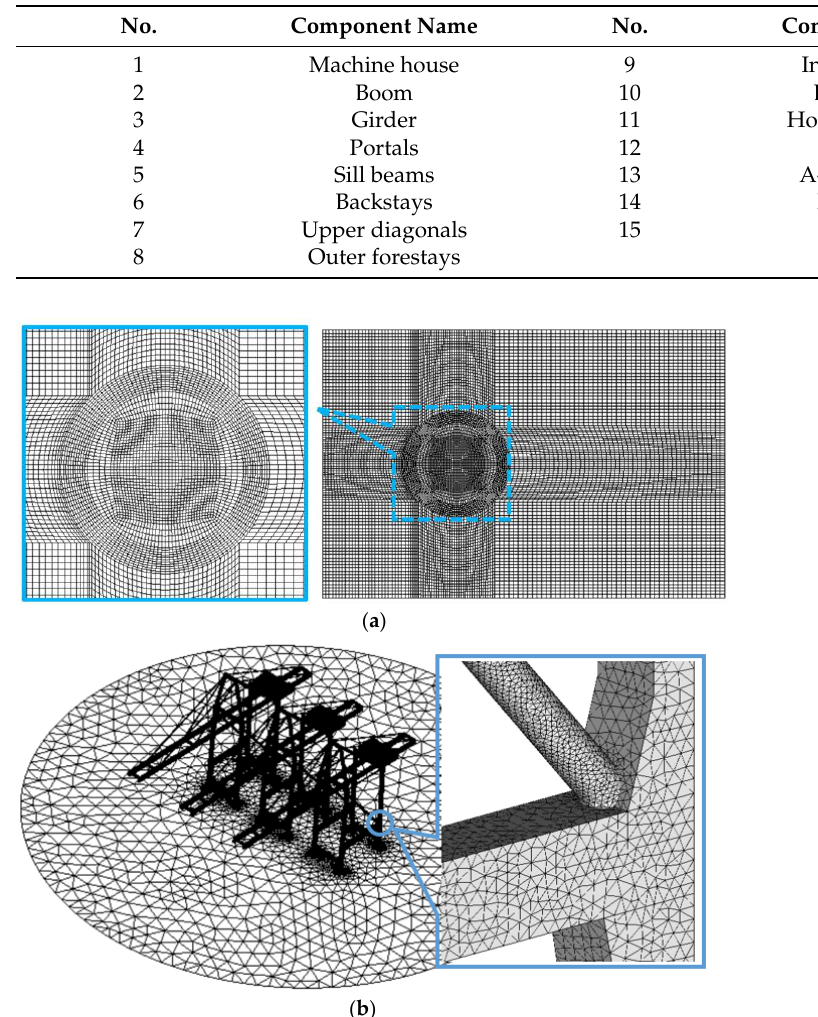
Figure 6. Grid diagram of the computational domain: ( a ) interior part; and ( b ) exterior part.